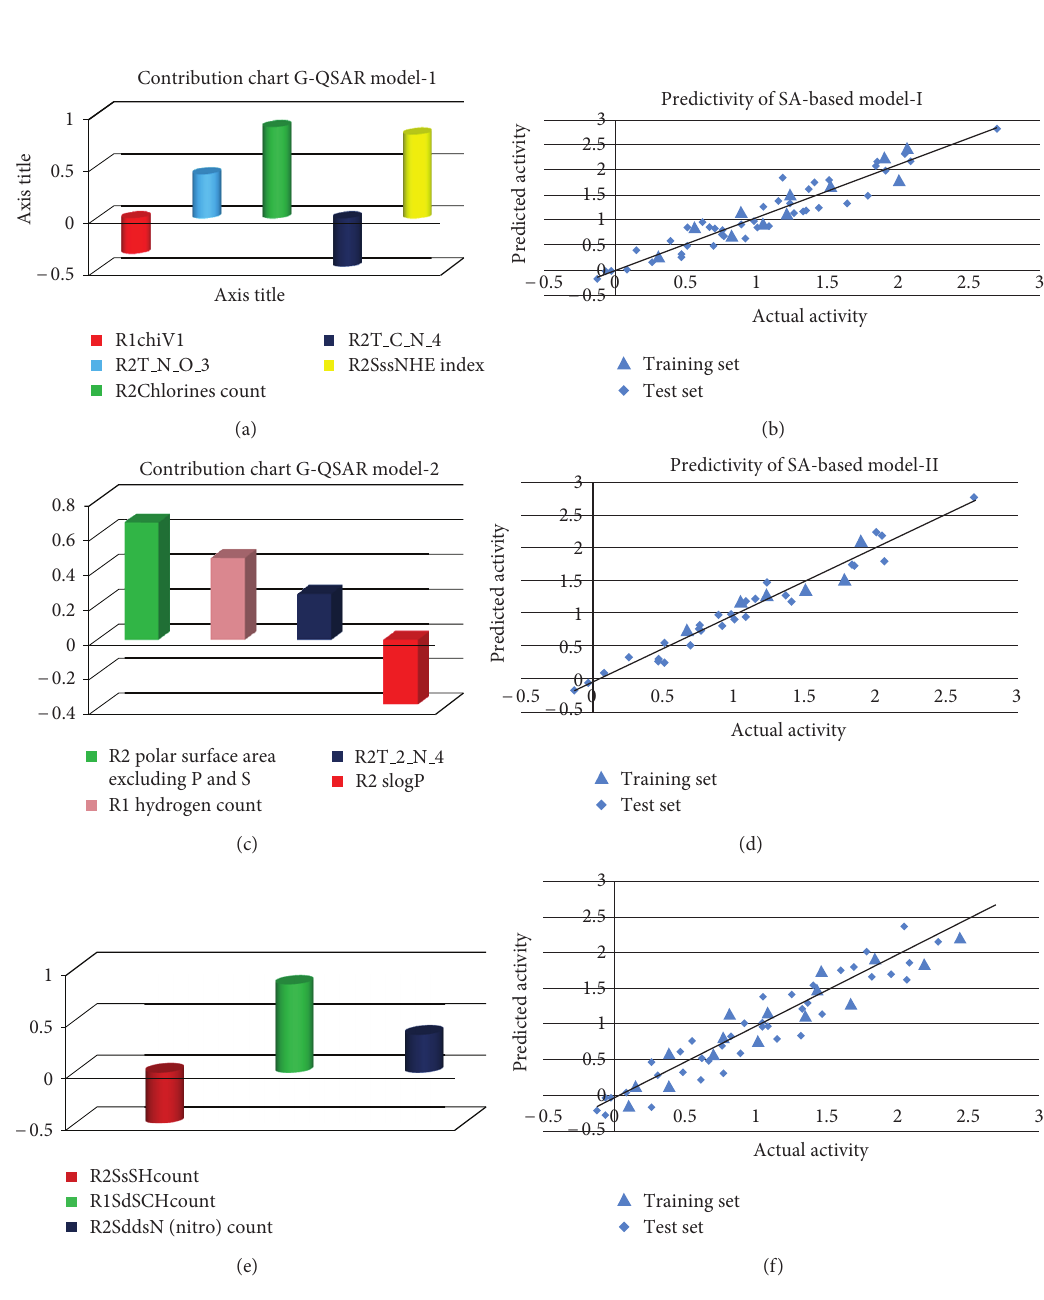
F 2: (a) Contribution charts of the descriptors for the model 1. (b) Graph of Actual and predicted activities of the training and test set GQSAR model 1 ( -Training set, -test set). (c) Contribution charts of the descriptors for the model 2. (d) Graph of Actual and predicted activities of the training and test set GQSAR model 2 ( -Training set, -test set). (e) Contribution charts of the descriptors for the model 3. (f) Graph of Actual and predicted activities of the training and test set GQSAR model 3 ( -Training set, -test ◆ ▴ ◆ ▴ ◆ ▴